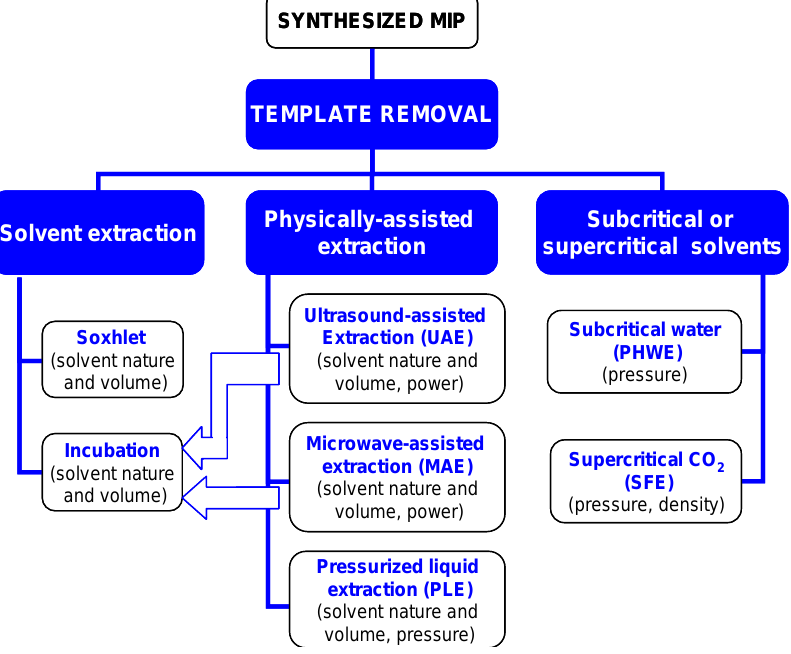
Figure 3. The three main approaches available for template removal: extraction with common solvents, physically-assisted solvent extraction, and extraction with subcritical or supercritical fluids. The variables that determine the yield of each process, in addition to temperature and time, and the interrelations among the techniques are also